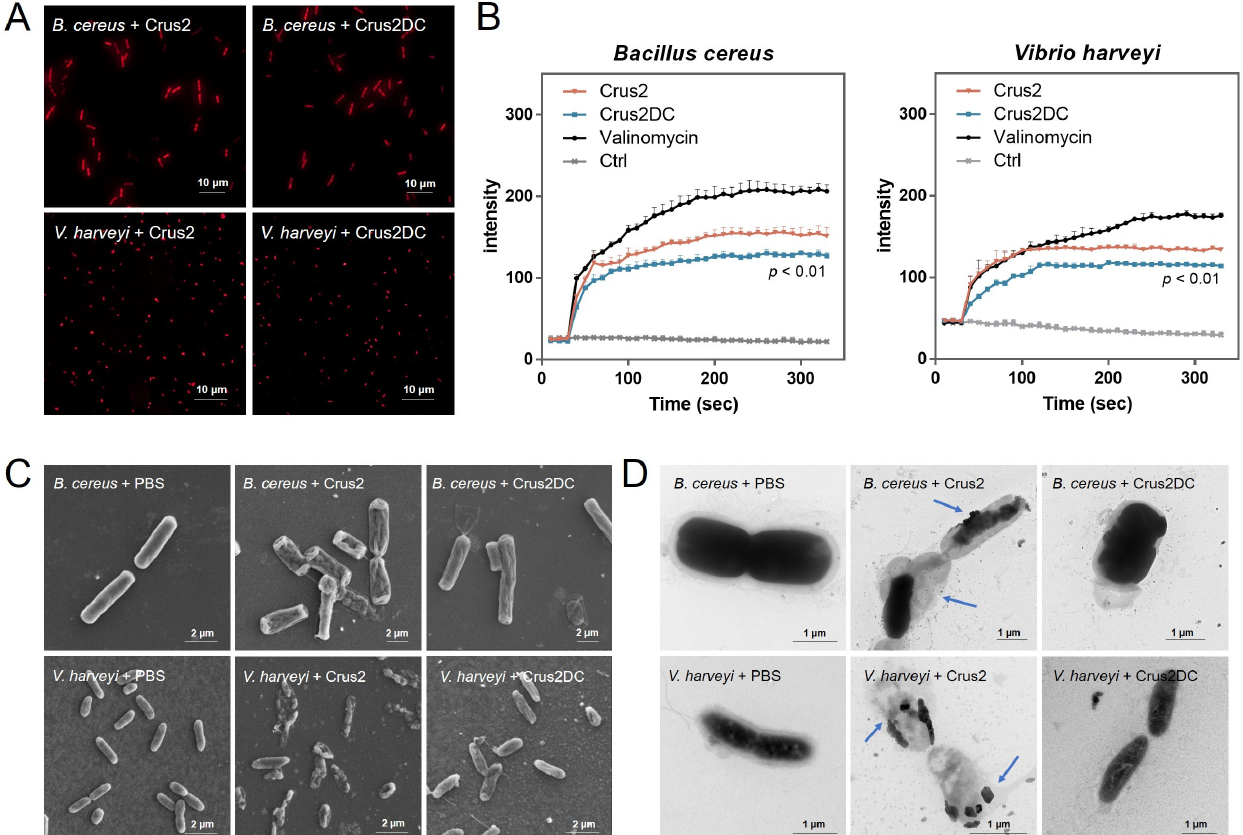
Figure 3. The effect of Crus2/Crus2DC on bacterial structure. ( A ) Bacteria ( Bacillus cereus or Vibrio harveyi ) were treated with Crus2 or Crus2DC. After treatment, PI was used to stain the cells, and the stained cells were observed with a fluorescence microscope. ( B ) The above bacteria were first treated with DiSC3 (5) and then treated with or without (Ctrl) Crus2, Crus2DC, or valinomycin, and the fluorescence of the cells was subsequently determined. ( C , D ) B. cereus and V. harveyi were incubated with Crus2, Crus2DC, or PBS. After incubation, scanning ( C ) or transmission ( D ) electron microscopy was applied for structural observation. The blue arrows indicate the breakdown of cellular structure and the release of cellular contents.